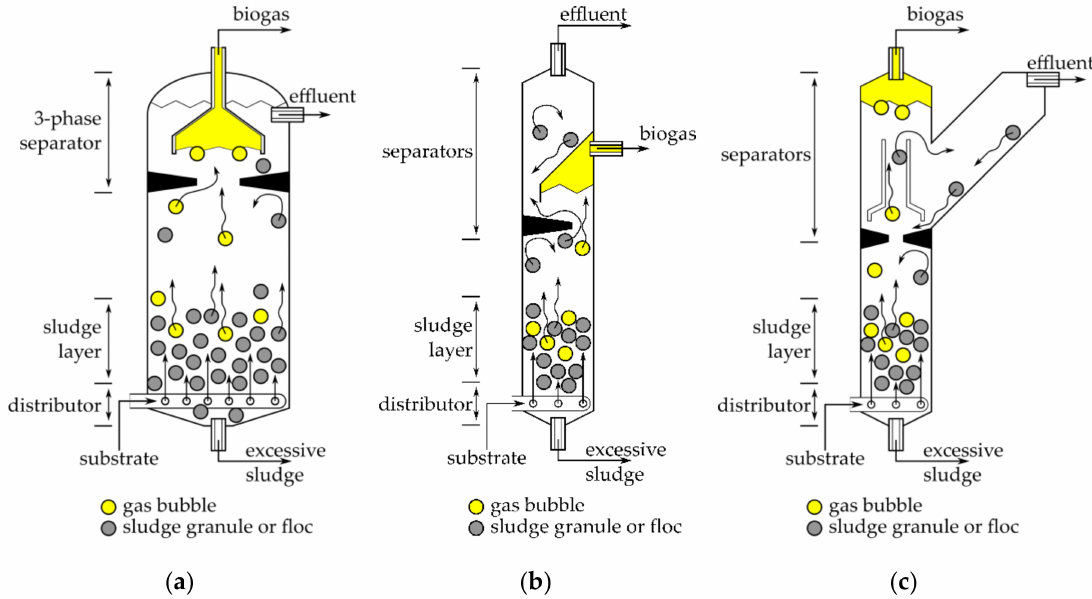
Figure 1. Operational concept of traditional Up-flow Anaerobic Sludge Blanket (UASB) reactors: ( a ) traditional; ( b ) with modified gas collector; and ( c )